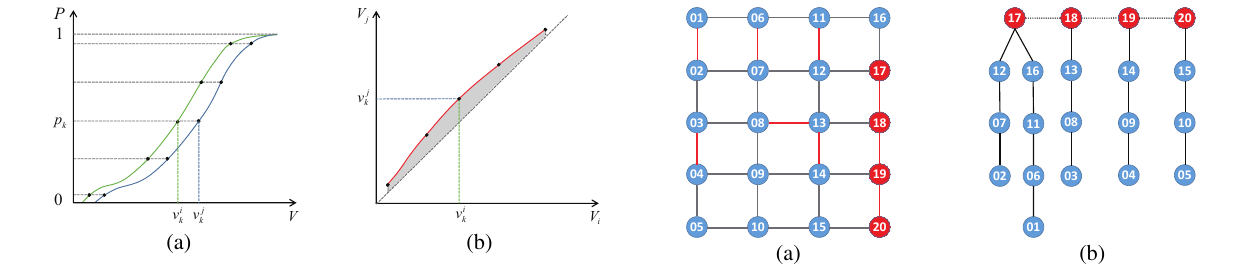
node. Figure 5 illuminates the procedure of finding the optimal correction order.